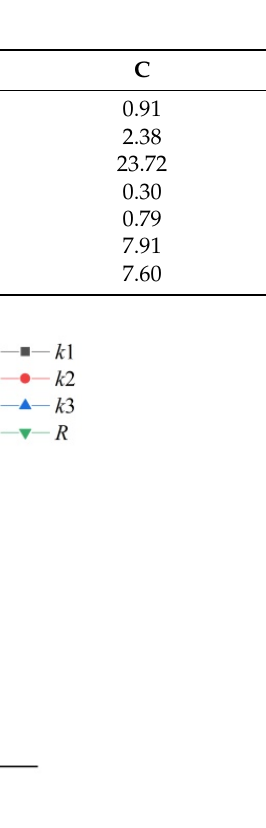
Figure 10. Range analysis of the orthogonal experiment.